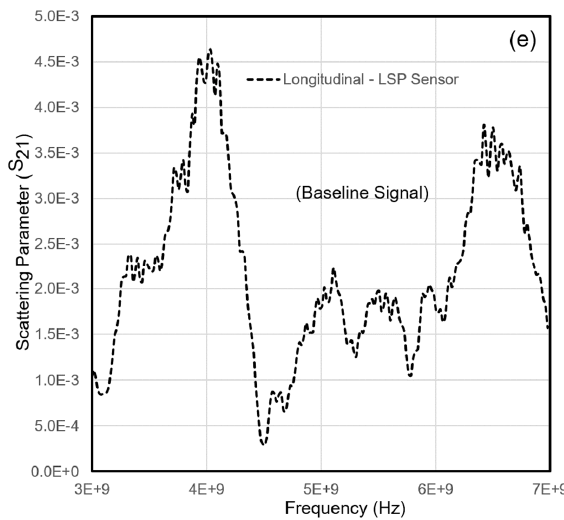
Figure 3. Representative LSP sensors and output ( a ) radial-LSP sensor, ( b ) longitudinal-LSP sensor, ( c ) probing in Near Field, ( d ) baseline signal of Radial-LSP sensor, and ( e ) baseline signal of longitudinal-LSP sensor.